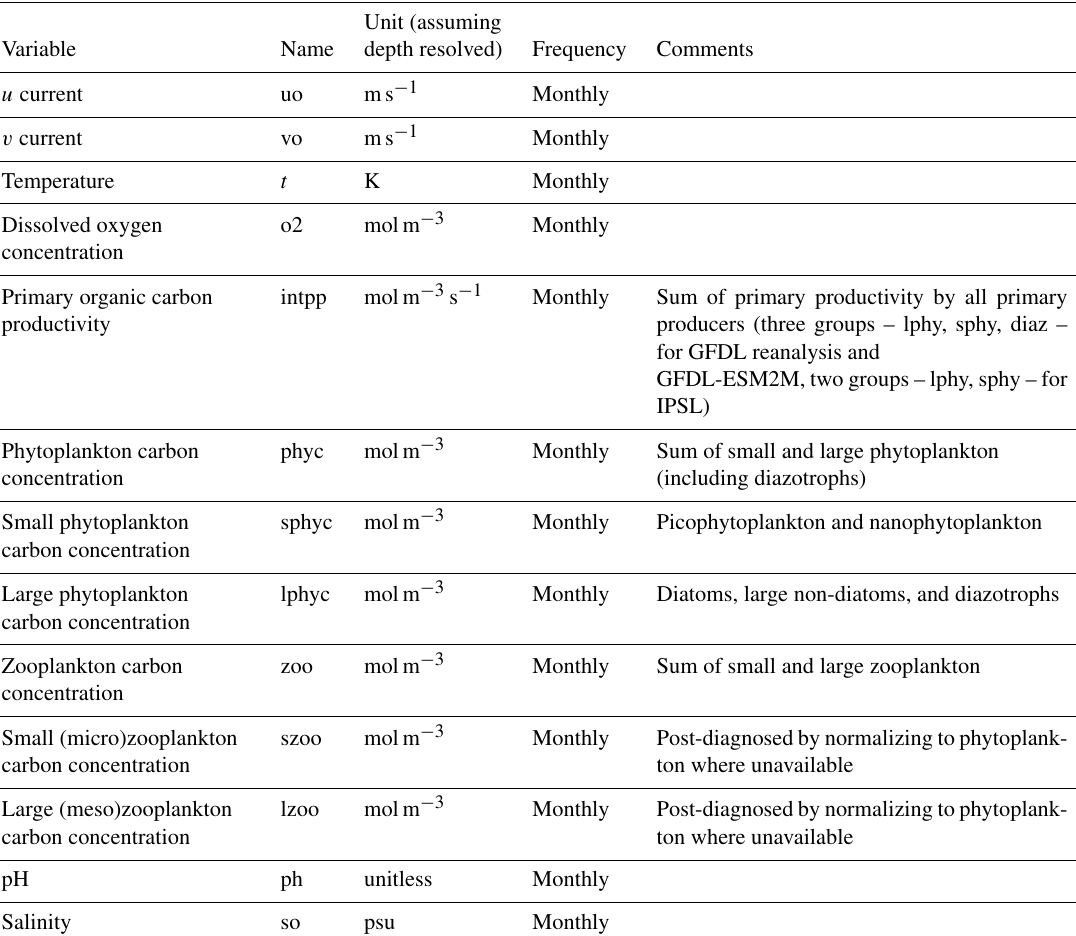
Table 3. Forcing variables derived from Earth system models and provided as input for global and regional marine fisheries models. Names and units follow CMIP5 standard output